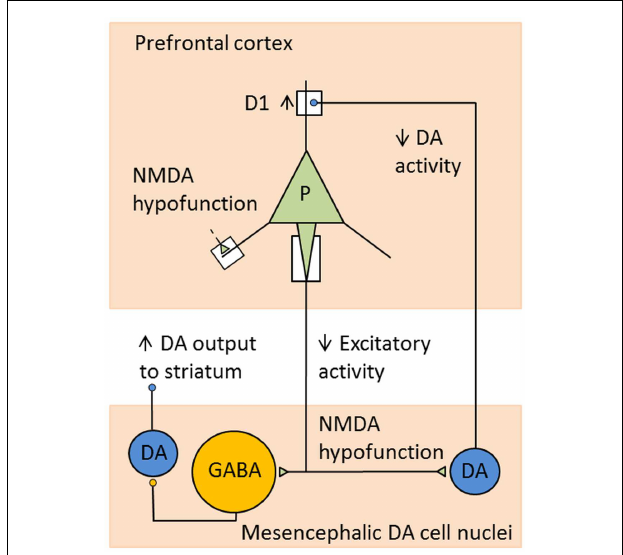
FIGURE 1 | Example for consequences of NMDA receptor hypofunction in glutamatergic–dopaminergic circuits . Hypofunction of NMDA receptors mediating excitatory inputs to prefrontal pyramidal cells in schizophrenia leads to decreased activity in cortical excitatory projections to mesencephalic DA cell nuclei.This results in decreased activity of DA neurons projecting to the DLPFC and increased activity of DA cells projecting to the striatum, as a consequence of decreased stimulation of GABA interneurons. Reduced DA levels in DLPFC lead to compensatory, but functionally insufficient, upregulation of D1 receptors [adapted from Lewis and Gonzalez-Burgos